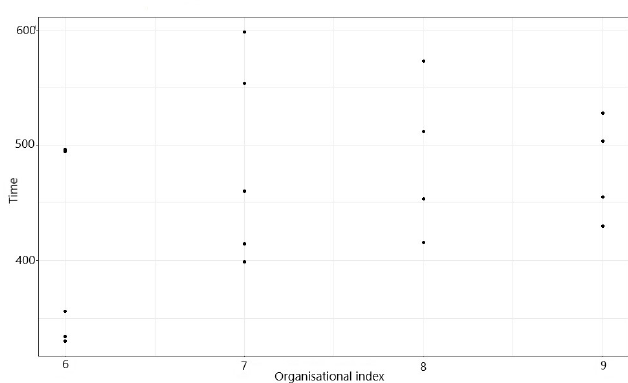
Figure 9. Time taken to complete rescue vs. Org index for 12-room simulations.